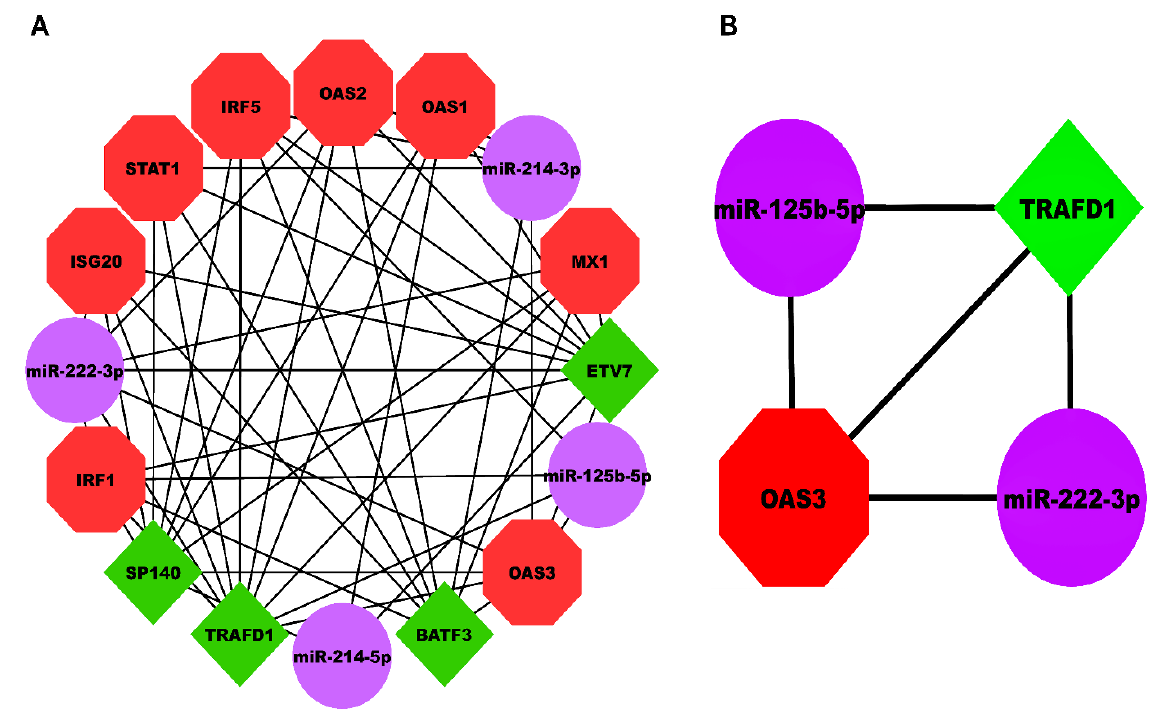
Figure 5. ( A ) HEV-specific three-node miRNA FFL comprising 16 nodes and 51 edges. ( B ) Highest- order subnetwork motif comprising one TF ( TRAFD1 ), one miRNA (miR-222-3p), and one mRNA ( OAS3) . Red-colored octagonal nodes signify hub mRNAs, green-colored diamond nodes signify TFs, and magenta-colored circular nodes signify miRNAs. HEV, Hepatitis E Virus; FFL, Feed-Forward Loop; TF, Transcription Factor; TRAFD1, TRAF-Type Zinc Finger Domain Containing 1; OAS3, 2'-5'-Oligoadenylate Synthase 3.